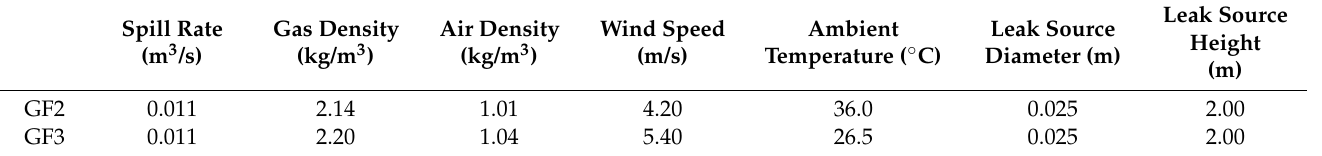
Table 1. Goldfish 2, 3 experiment information.